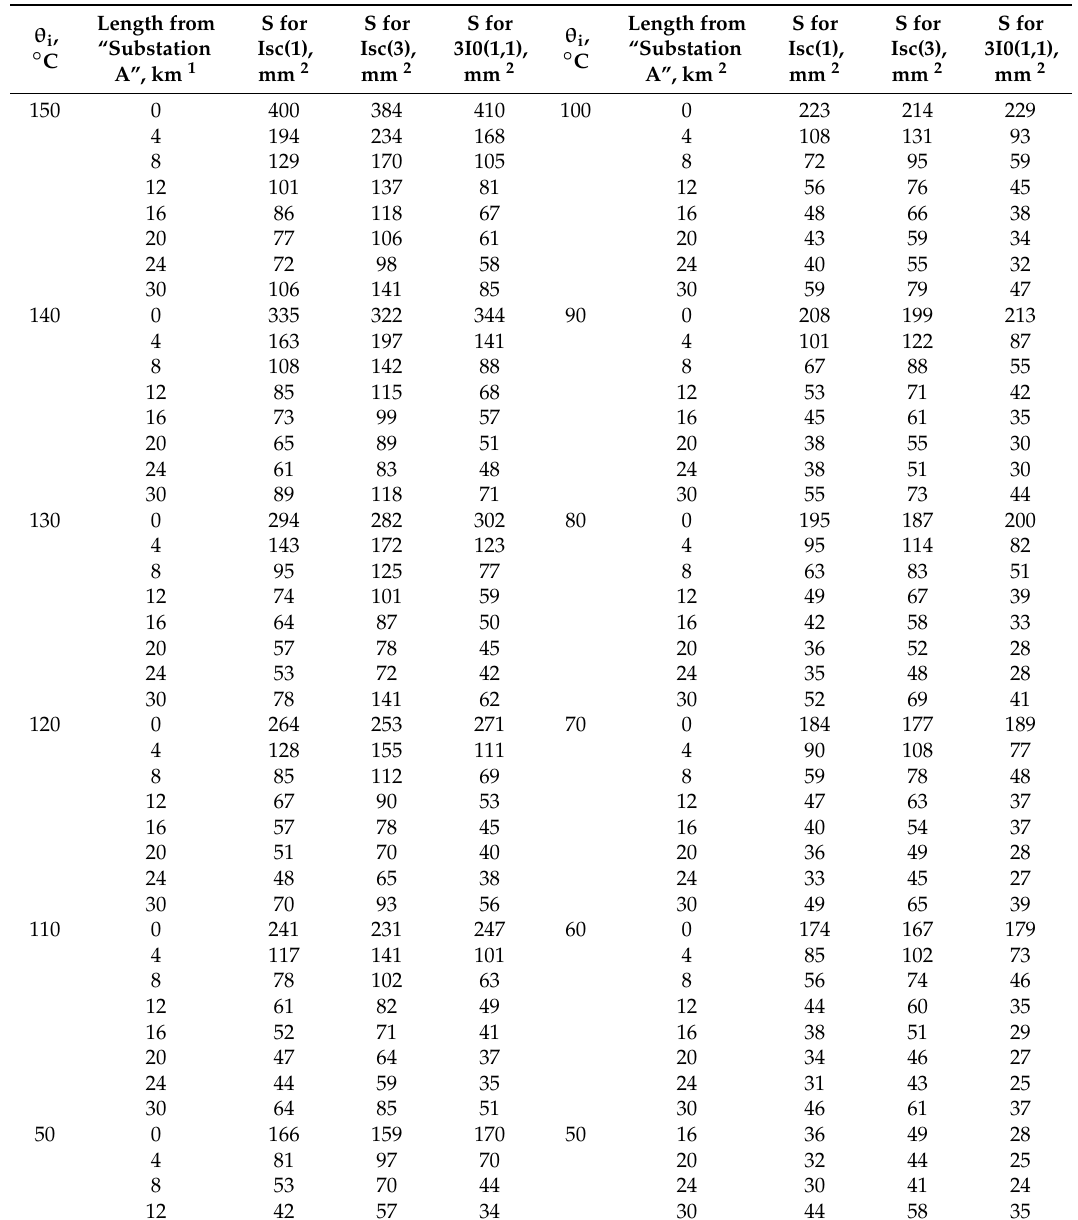
Table 1. Calculated minimum required cross-sectional area of conductor for “overhead power line (OHL) No.1” based on three estimated short-circuit